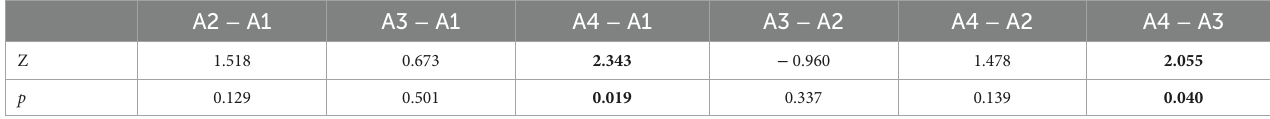
TABLE 2 Wilcoxon ranked sign test for the searching time when the target icon is linear type.